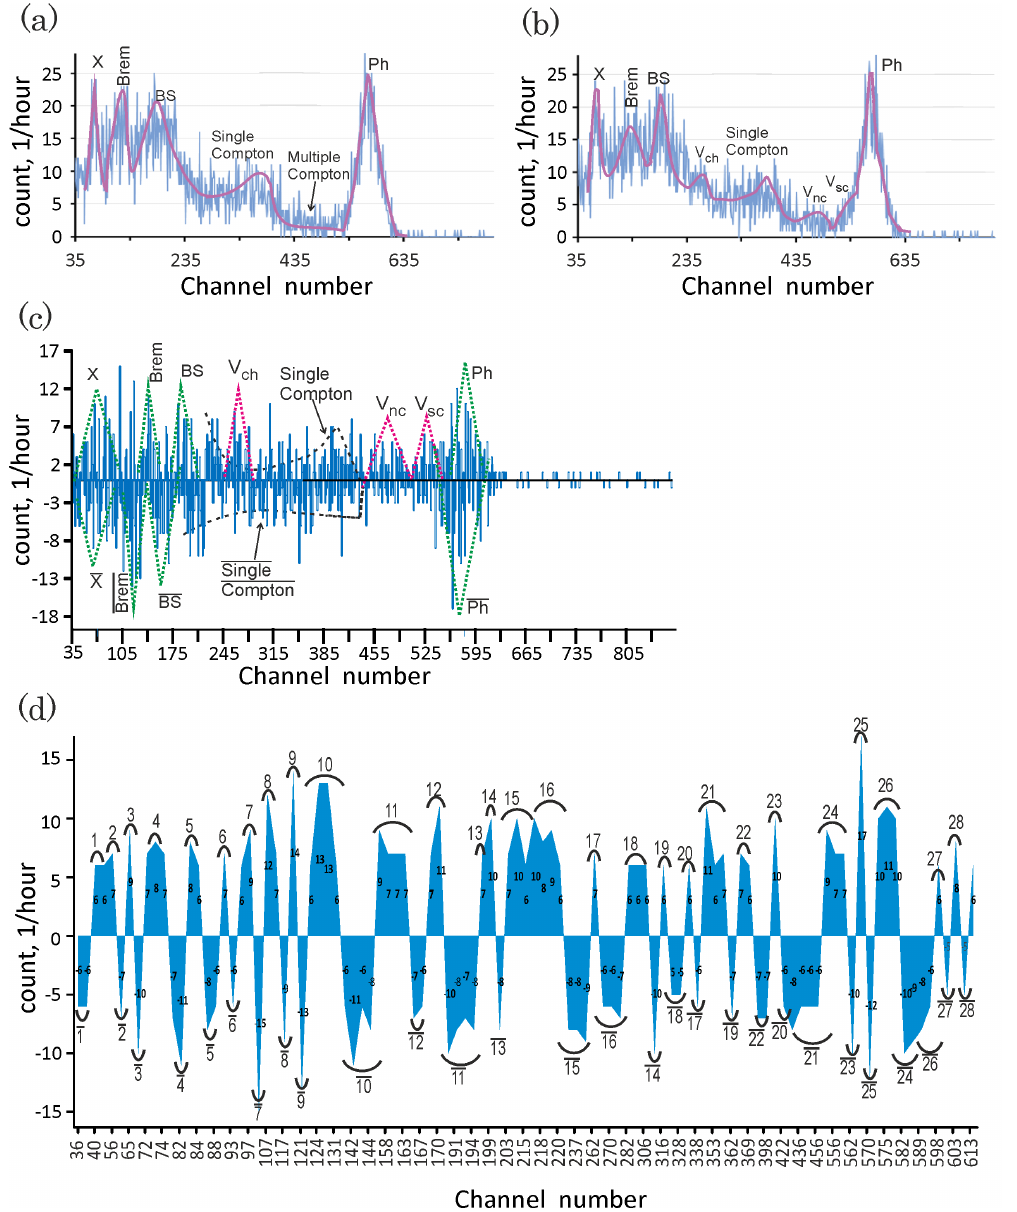
Figure 5. ( a ) The pulse height spectrum, R Cs , of the secondary electrons induced by the 137 Cs gamma quanta scattering on the crystal detector and ( b ) the pulse height spectrum, R CsG , of the secondary electrons collected following the impact of the 137 Cs gamma quanta on the bilayer target; the radiation background has been subtracted from the original distributions. ( c ) The difference, ∆ R , between the distributions of R CsG and R Cs : ∆ R = R CsG − R Cs ; the inverted peaks (antipeaks) related to the spectrum R Cs are marked by an overline. ( d ) Histogram of the bands and antibands formed by the channels of the difference spectrum inverted with respect to the spectrum in figure ( c ) for which the modules exceed 5 pulses/hour; the number of events for each channel of the bands and antibands is given before and after the placement of the absorber into the collimator,